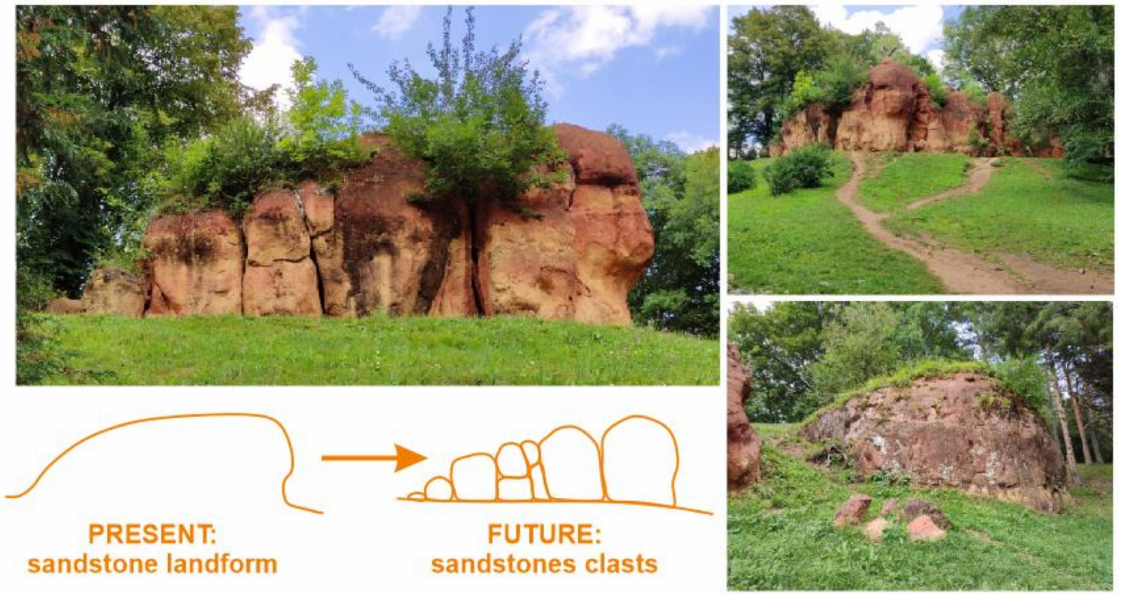
Figure 6. The Red Stones locality (see Figures 2 and 3 for location). Photos by